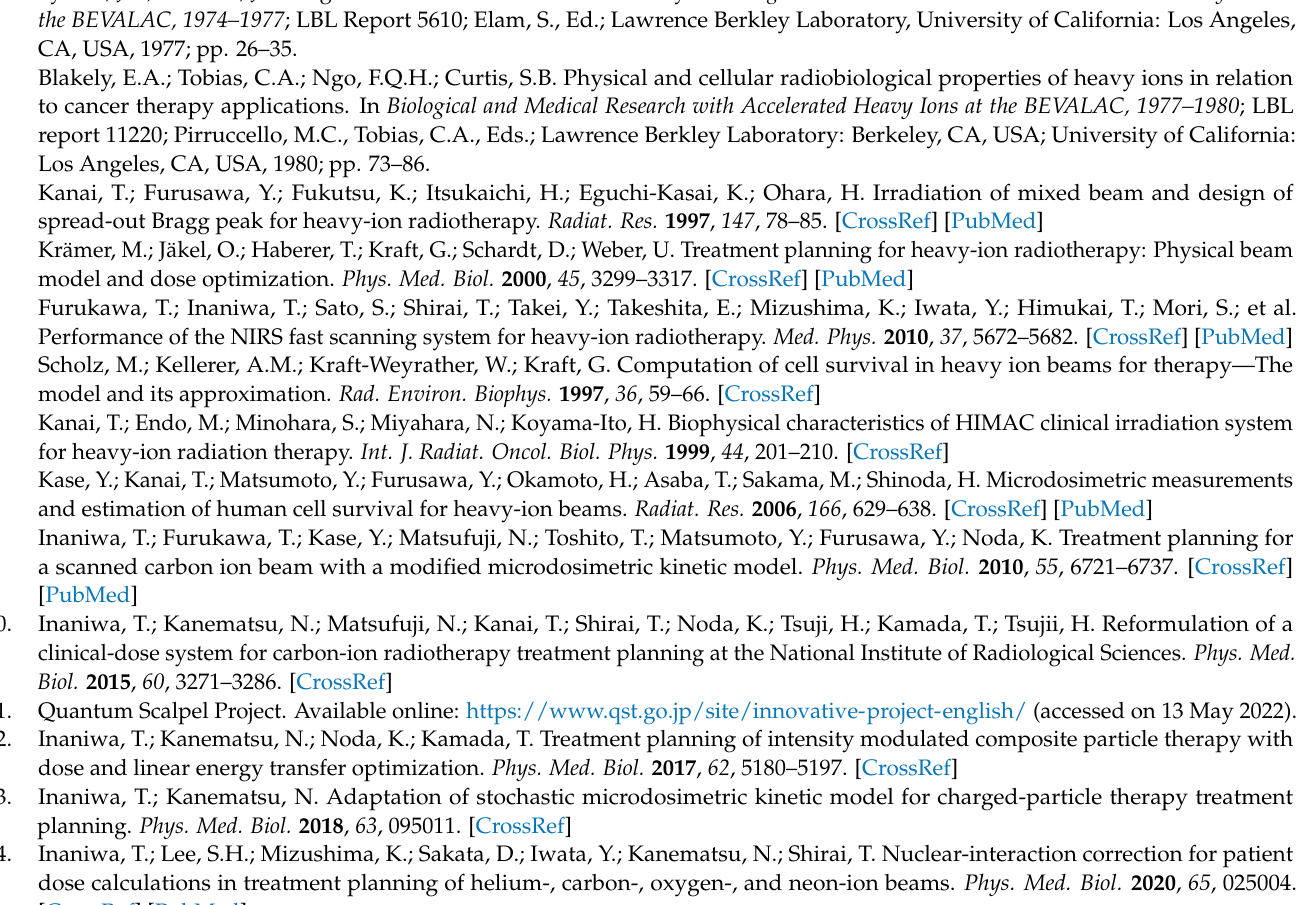
Figure A2. Energy calibration curves of ( a ) low gain and ( b ) medium gain. Standard deviation representing Gaussian fitting errors are included. Note that, at low gain, only ions other than 4 He ions are shown because 4 He ions with an energy of 170.5 MeV/u are not measurable at low gain for the LLD setting used.